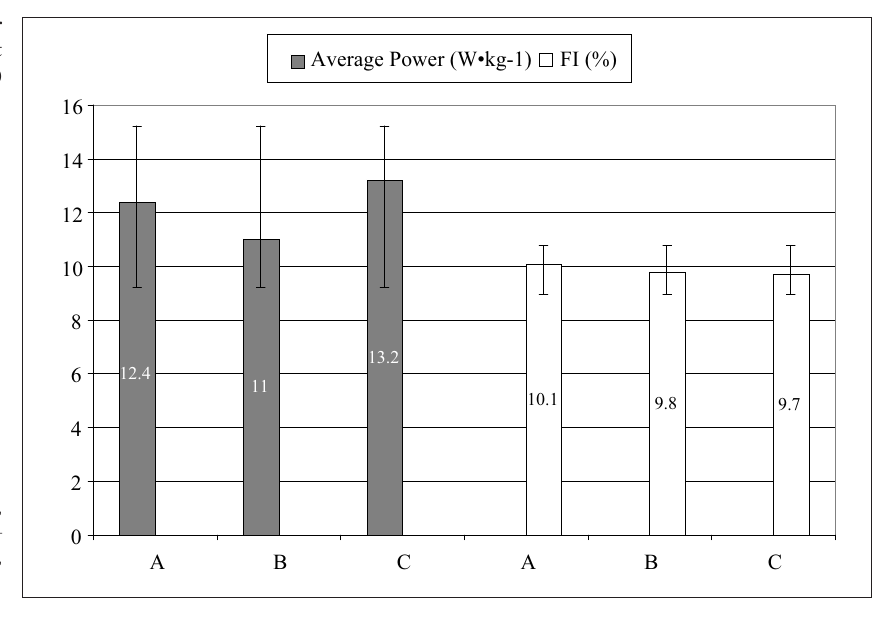
Figure 2. Average working power during 5 × 6 s repeated effort test (W·kg -1 ) and